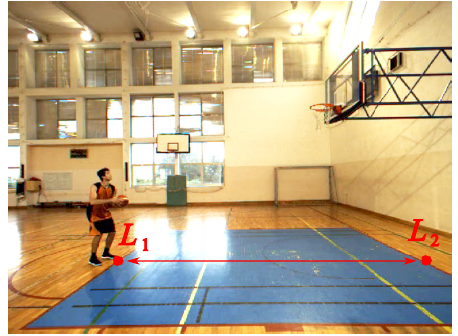
Figure 1. Block diagram of the ball detection and tracking